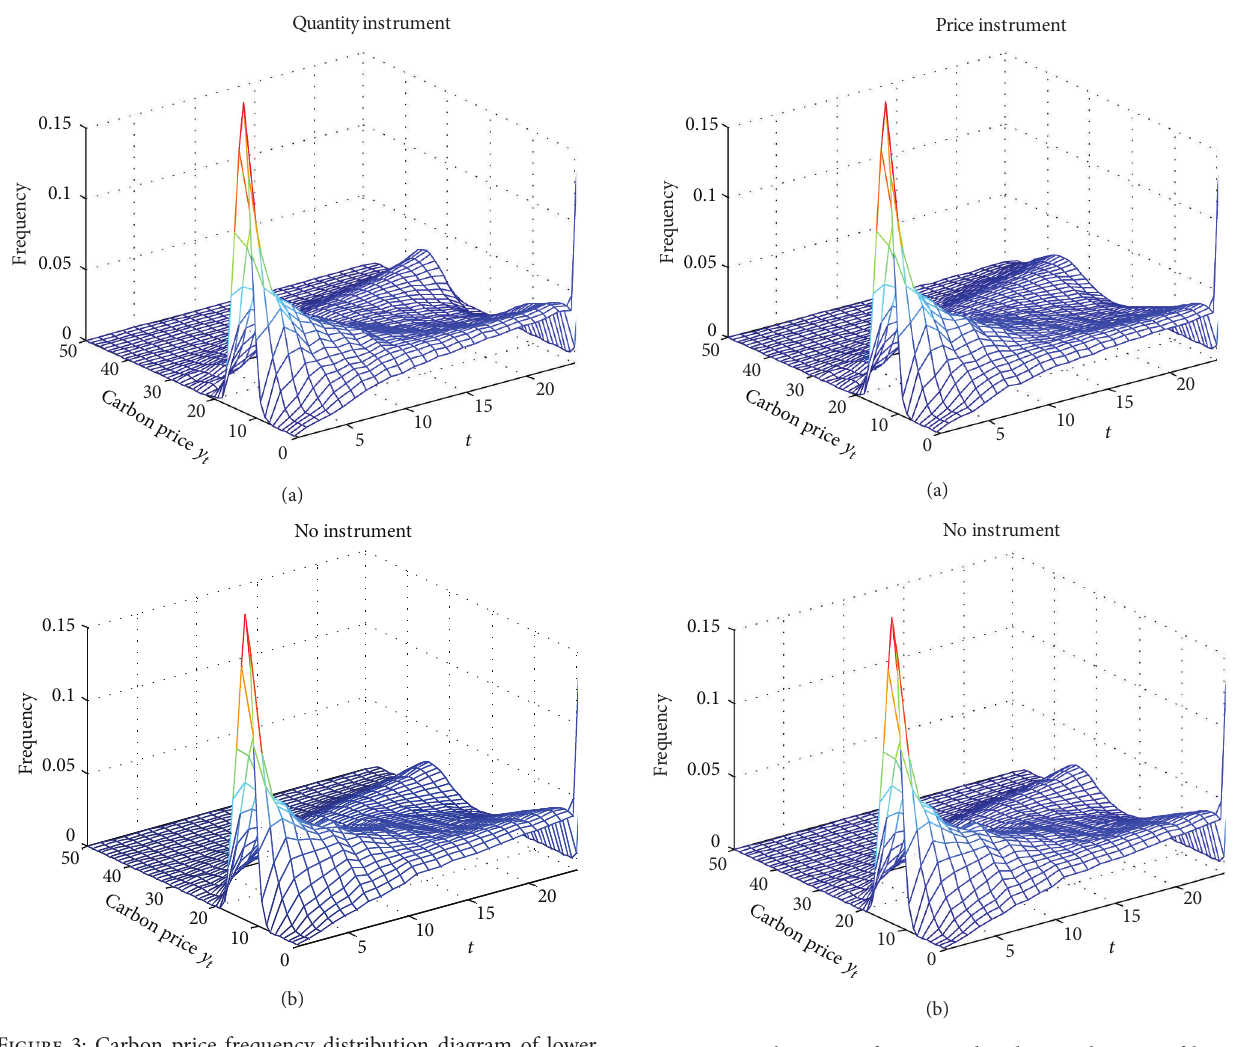
Figure 4: Carbon price frequency distribution diagram of lower threshold regulation using price